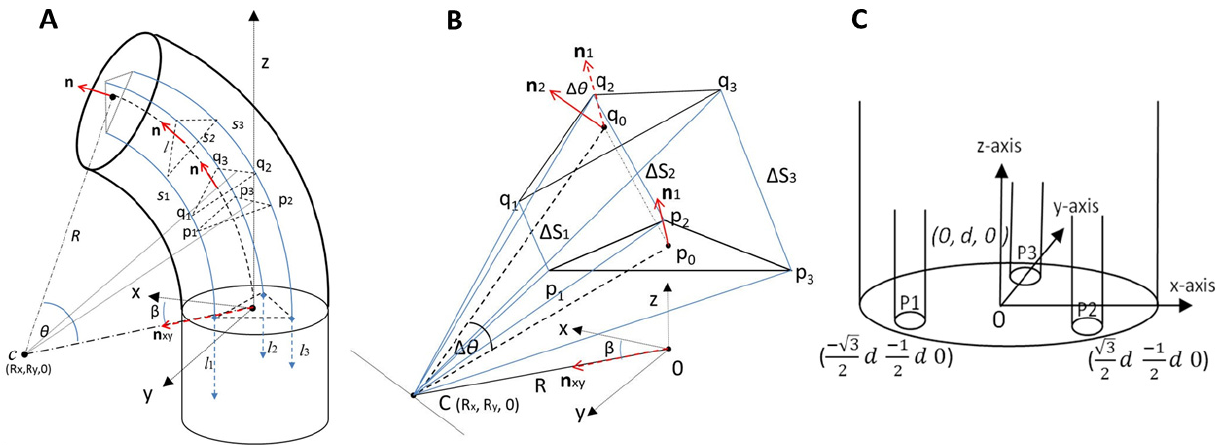
Figure 10. ( A ) Sketch of the bending module with its three inner conduits within which the wires move depending on amount and direction of movement. The centre of the circle assumed by the constant-curvature bend is at point c ; ( B ) The planes, p 1 p 2 p 3 and q 1 q 2 q 3 , form a pentahedron from which the bending radius and the centre point c can be computed; ( C ) The coordinates of the three conduits at the base of the flexible module; points p 1 , p 2 and p 3 are assumed to be located in the centre of each conduit [38].